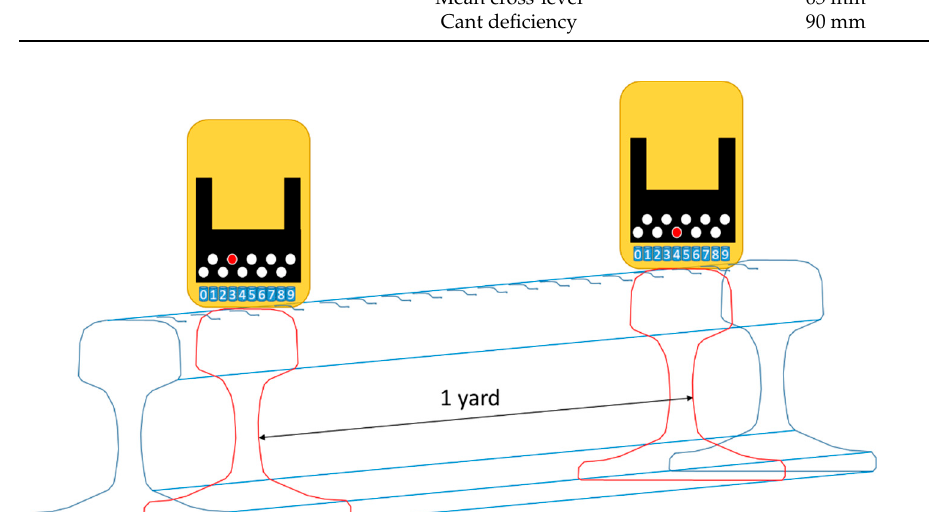
Figure 9. Track geometry of the considered sections: ( a ) Section 1; ( b ) Section 2. Two Eddy Current measurements are available, which were taken 220 days one after the other. Within this period of time, an estimated traveled load of 4.752 MTn is consid- ered for these sections. This value is calculated from daily traffic and load per axle detailed in Table 2. The inspection system provides data of rail sections every yard (0.914 m). Crack depth is measured at ten points on each section (see Figure 10) and the maximum value is taken as a reference for our assessment. Figure 10. Sketch of Eddy Current measurement system on a rail.